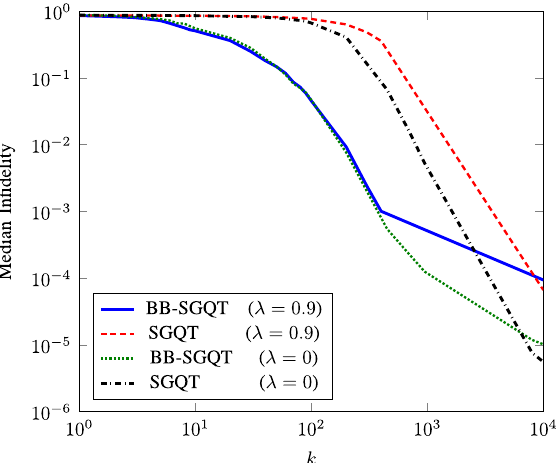
Figure 3. Average infidelity plots for d = 8 with 90% depolarizing noise (red and blue) and without noise (green and black) are plotted by taking the average for 100 randomly generated qubits using Haar measurements. Red and black represent standard SGQT graphs, while blue and green color is for our BB-SGQT method. Here, we fixed N = 10 4 the number of measurements per iterations for each